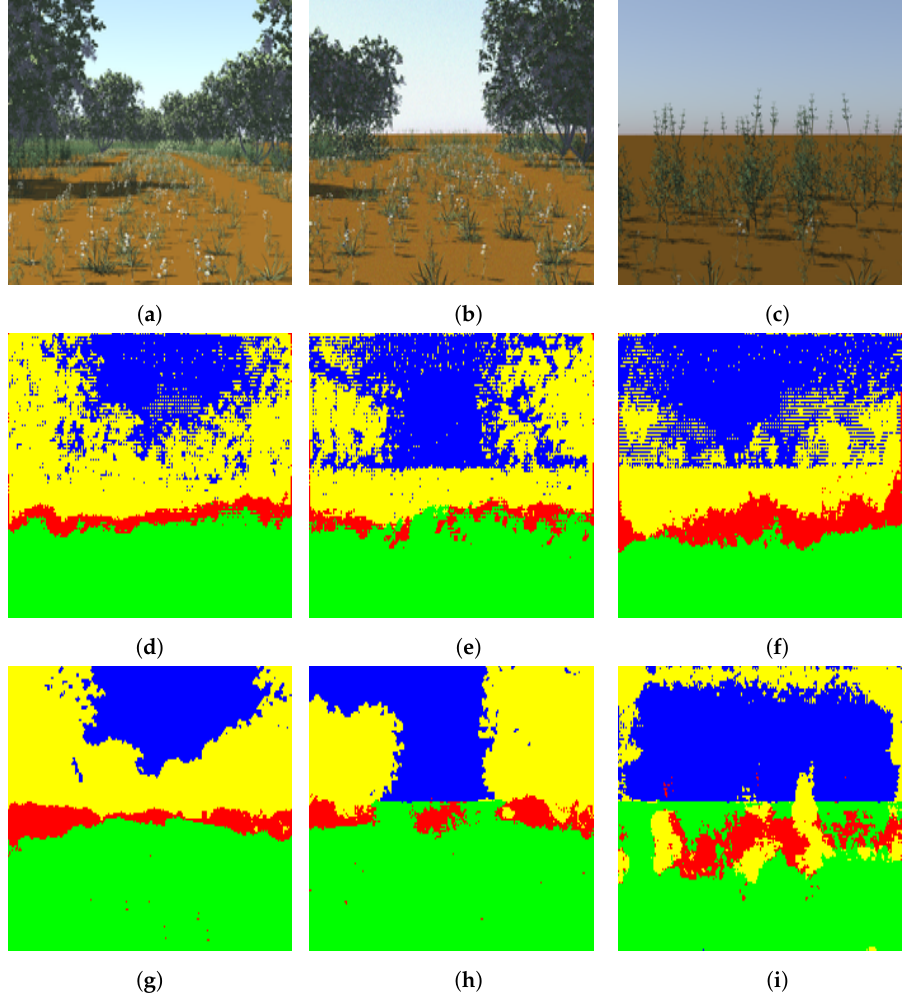
Figure 8. Segmentation of the four-class high-definition dataset ( a – c ): test images, ( d – f ): segmented images using DeconvNet, ( g – i ): segmented images using proposed light-weight network. Note that the color code for classes is: green: ground, red: vegetation, yellow: tree, blue: sky. Best viewed in